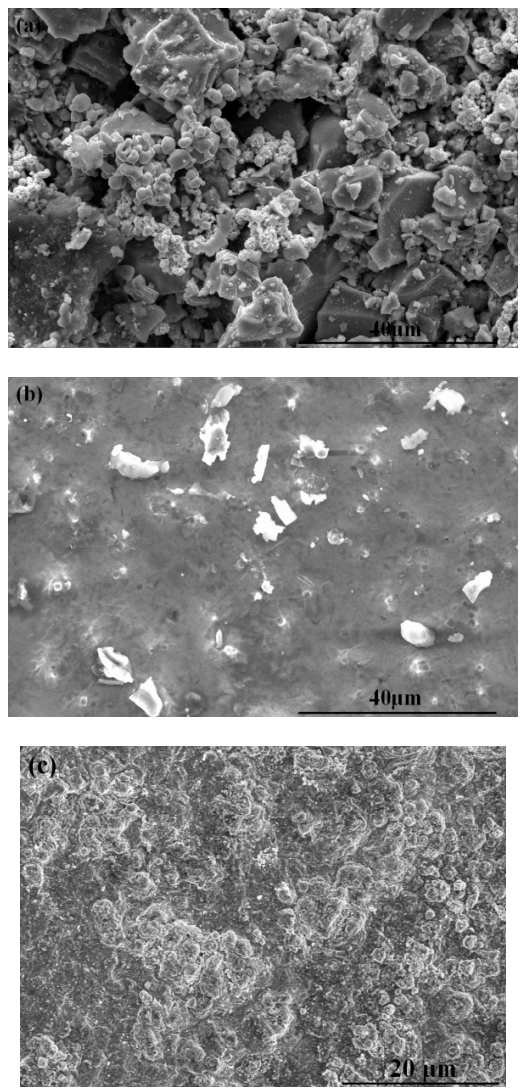
Figure 2. Scanning electron microscopy (SEM) micrographs of the ( a ) preplaced coating, ( b ) laser cladding cermet coating, and ( c ) multi-scale cermet coating.